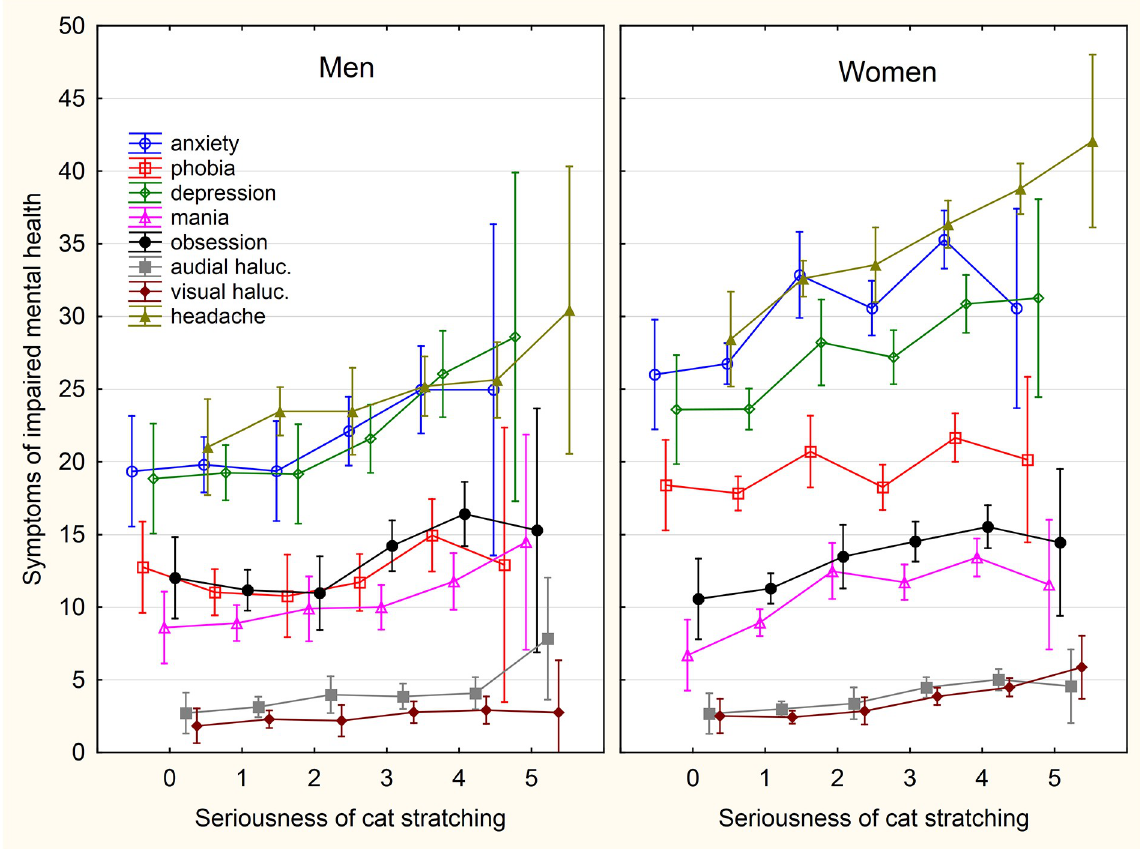
Fig 8. Association between intensity of sustained cat scratching and symptoms of impaired mental health. The categories on x-axis describing the intensity of being injured by a pet are: 0- never, 1- only while playing, 2- only as a warning, 3- yes, minor injury (only skin cut), 4- yes, moderate injury (bleeding), 5- yes, serious injury, I had to seek medical